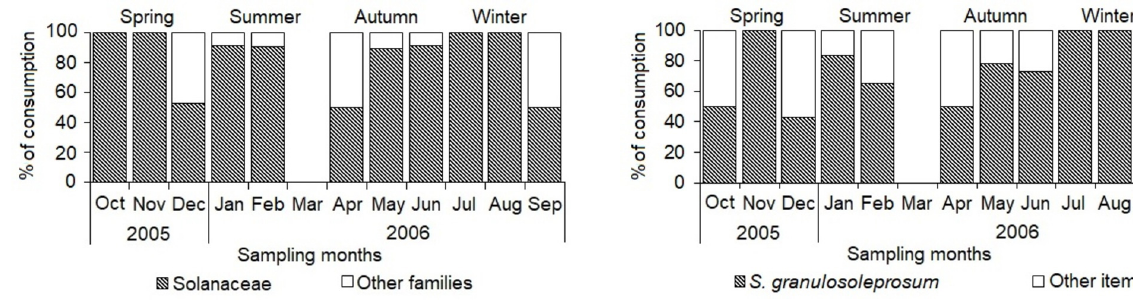
Figure 2. Seasonal percentage of consumption (number of fecal samples with seeds) of S. granulosoleprosum and other items in the diet of S. lilium